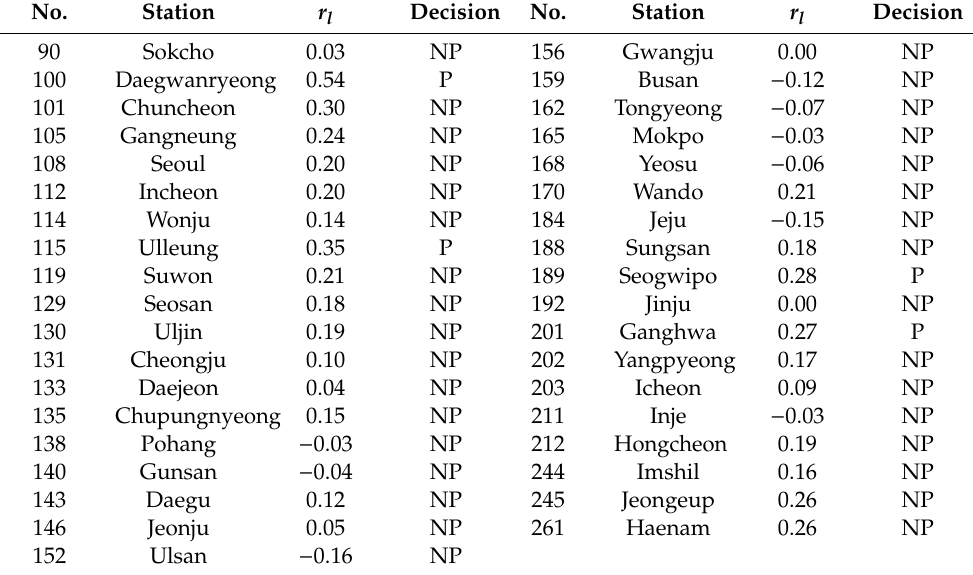
Table 2. Serial correlation coefficient analysis for annual precipitation data.